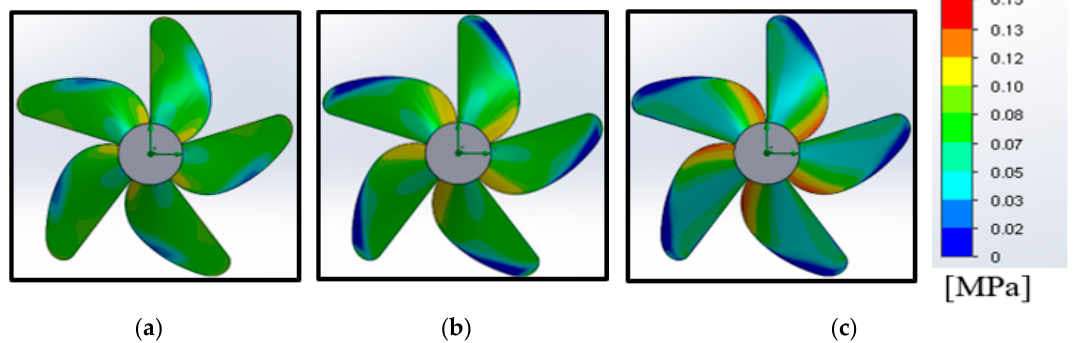
Figure 10. Streamline distribution on the blade pressure side at various TSR : ( a ) TSR = 1.0; ( b ) TSR = 2.0; ( c ) TSR = 4.0. Figure 11. Contour of pressure on the blade pressure side for various TSR : ( a ) TSR = 1.0; ( b ) TSR = 2.5; ( c ) TSR = 4.0.